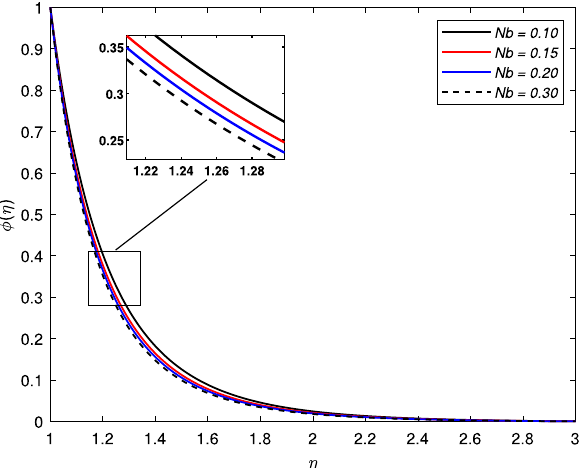
Figure 11. Impact of Brownian motion parameter Nb on concentration profile φ(η) .